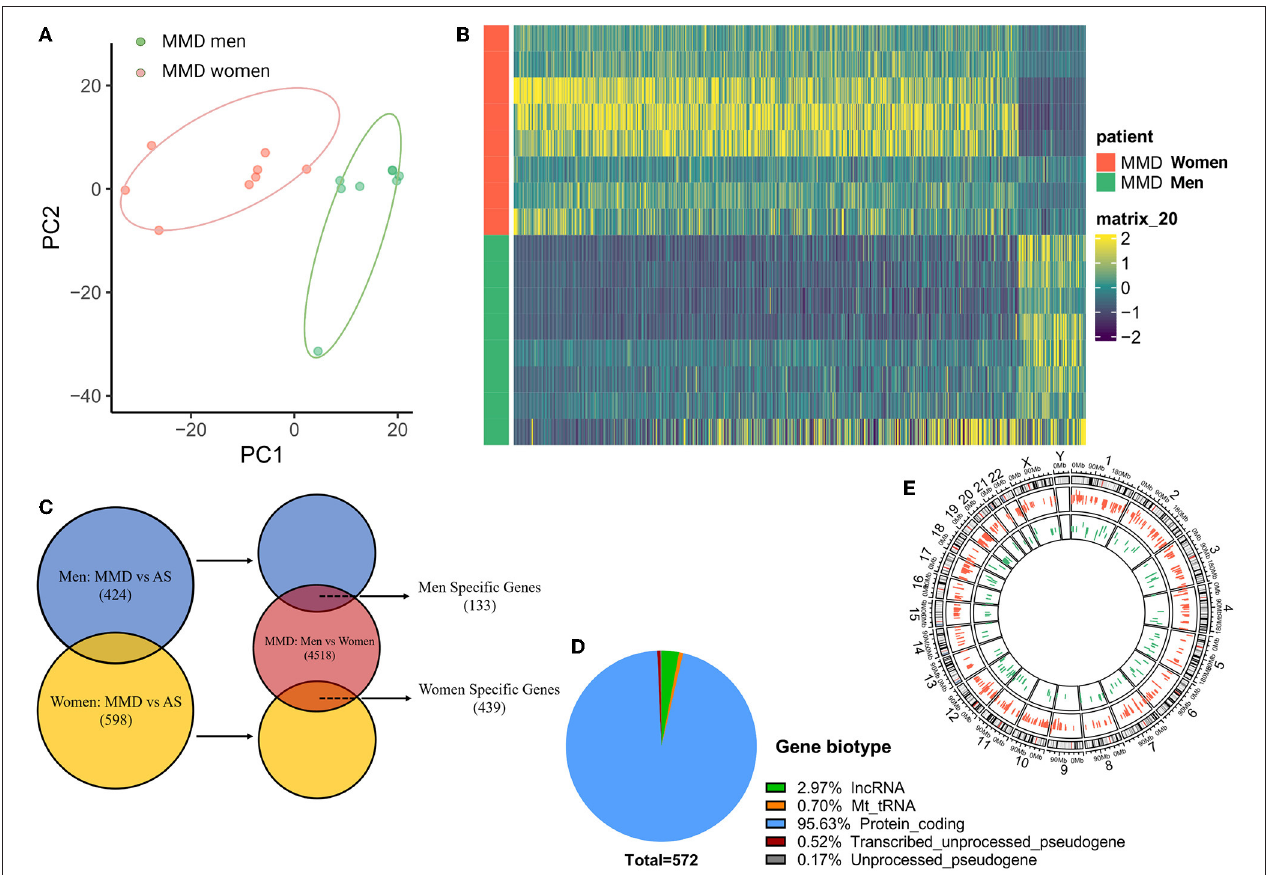
FIGURE 5 | Sex differences between adult men and women patients with MMD. (A) PCA analysis, performed using all of the normalized values obtained from the sequencing data, showed two separate clusters for men and women with MMD. Green dots represent men patients with MMD, red dots represent women participants with MMD. (B) Heatmap showed a distinct gender expression pattern of DEGs in MMD. The color key at the right indicates a relative gene expression. Yellow and green colors represent higher and lower gene expression levels, respectively. (C) Venn plot of sex-specific DEGs showed specific genes in men and women patients with MMD. Blue color represents men with MMD vs. men with AS-ICASO, yellow color represents women with MMD vs. women with AS-ICASO, and orange color represents men with MMD vs. women with MMD. (D) Gene biotype of all sex-specific genes. (E) Chromosome distribution of sex-specific genes shows that 95.49 and 96.59% of the genes are autosomal genes in men and women, respectively. Green bar represents men patients with MMD, red bar represents women